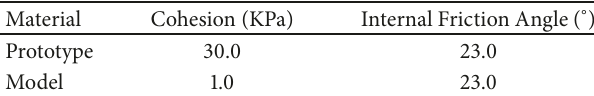
Table 1: Mainmechanicalparametersof similar materialprototypes and